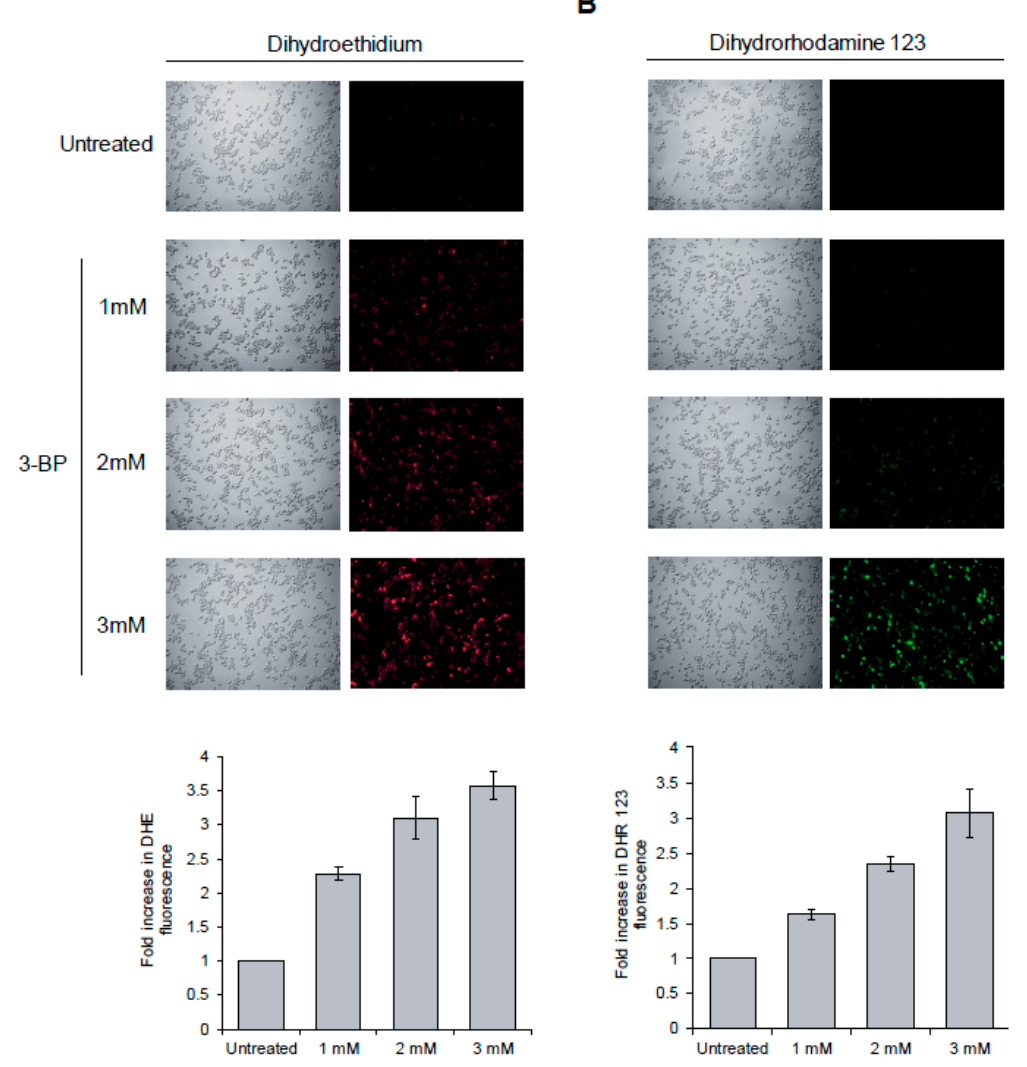
Figure 4. 3-BP induces reactive oxygen species (ROS) formation. ( A , B ) 3-BP0000000 treatment results in generation of ROS. A logarithmically growing culture of wild type cells pre-loaded with dihydroethidium ( A ) or dihydrorhodamine 123 ( B ) was treated with indicated concentrations of 3-BP for 2 h. Fluorescence was detected using a fluorescence microscope and quantified with a fluorescence plate reader. Error bars represent mean value ± standard deviations of mean ( n = 3). Average fluorescence value for untreated cultures was set to 1.